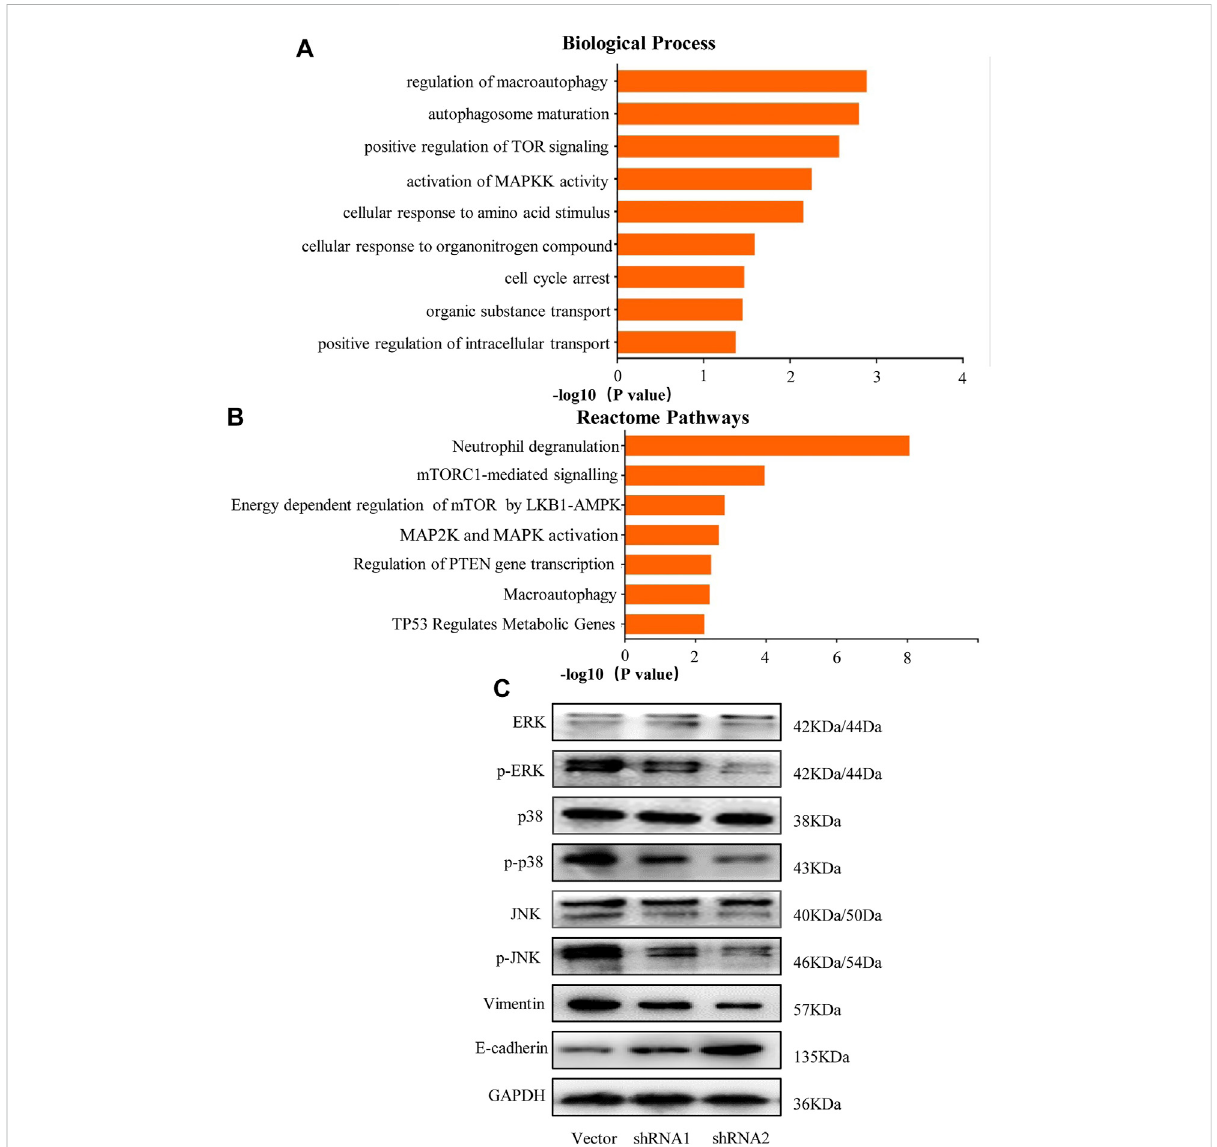
FIGURE 5 CMTM6activatesMAPKsignalingtoregulateEMT. (A,B) Pathwayenrichment,biologicalprocess,andreactomepathwaysanalyses. (C) Western blotting showing the levels of MAPK-related proteins. Data were normalized to the level of GAPDH. * p < 0.05; ** p < 0.01; *** p <